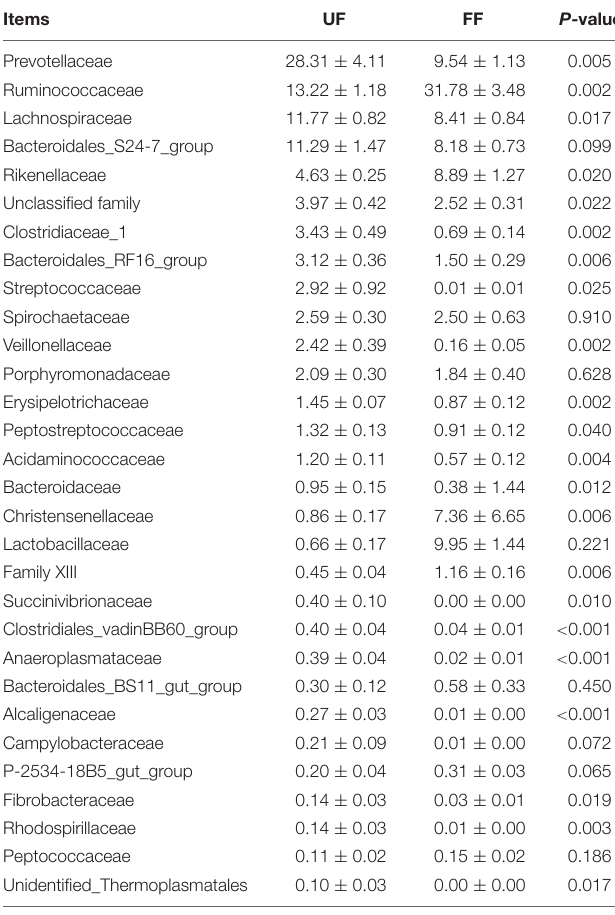
TABLE 8 | Relative abundance (percentage) for the top 30 most abundant family in the colon of pigs in the fermented feed (FF) and control (UF) groups. Items UF FF P